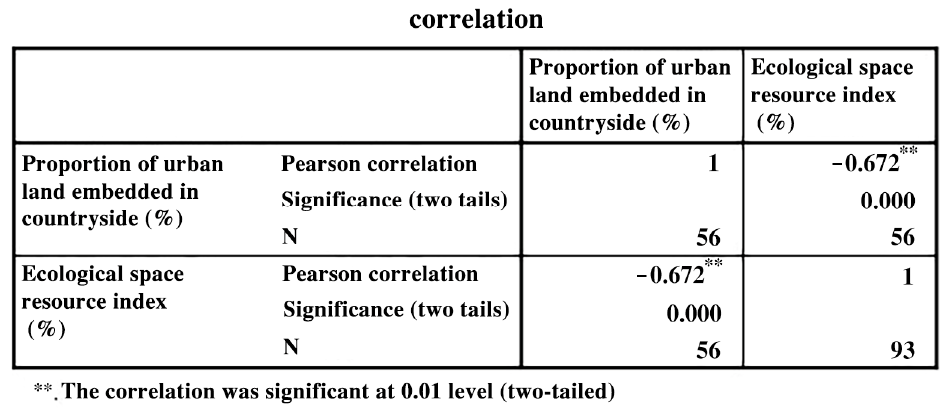
Figure 10. ( a ) Equation fitting analysis of the proportion of urban construction land and the ecological space resource index (source: self-drawn). ( b ) Correlation analysis between the proportion of urban construction land and the ecological space resource index (source: self-drawn).